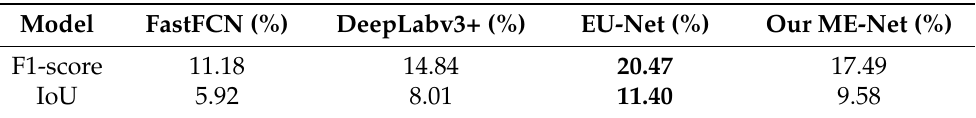
Table 7. Building edge detection results on the Inria test set in terms of F1-score and IoU, the best values are masked as bold.